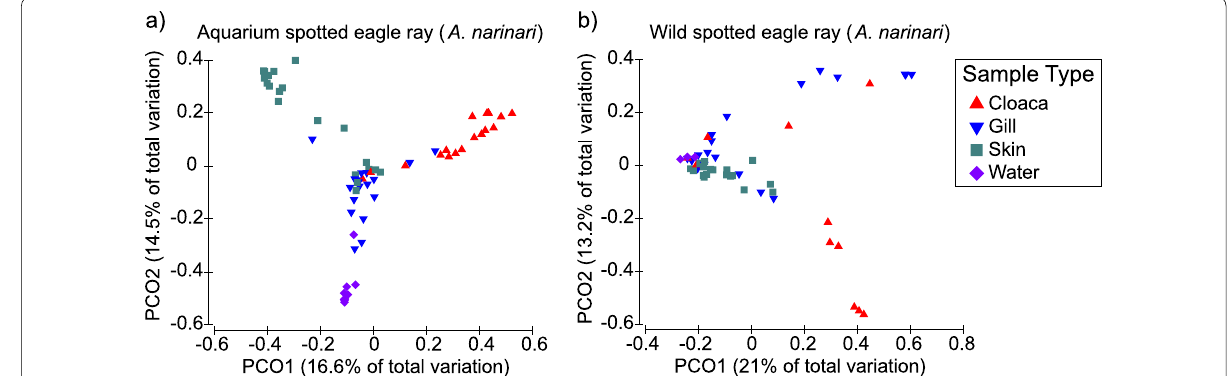
Fig. 4 Principal coordinate analysis (PCoA) based upon Bray–Curtis dissimilarity matrices between cloaca, gill, skin, and water for a aquarium whitespotted eagle rays ( Aetobatus narinari ), and b wild whitespotted eagle rays. Note that different body sites have different microbial community structures that differ from the surrounding water, as indicated by the separate clustering. In aquarium whitespotted eagle rays, the gills appear more similar to the surrounding water, while the skin is more similar to the surrounding water in wild whitespotted eagle